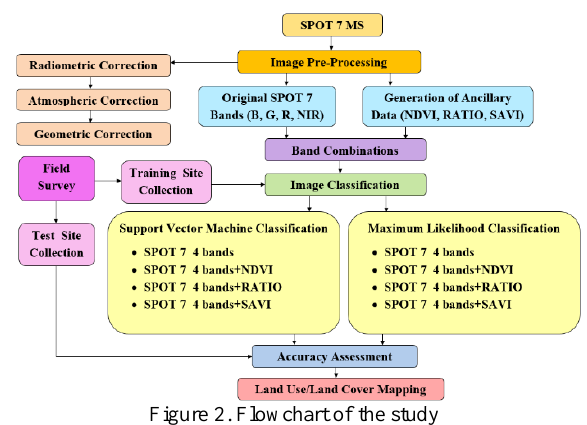
Figure 2. Flowchart of the